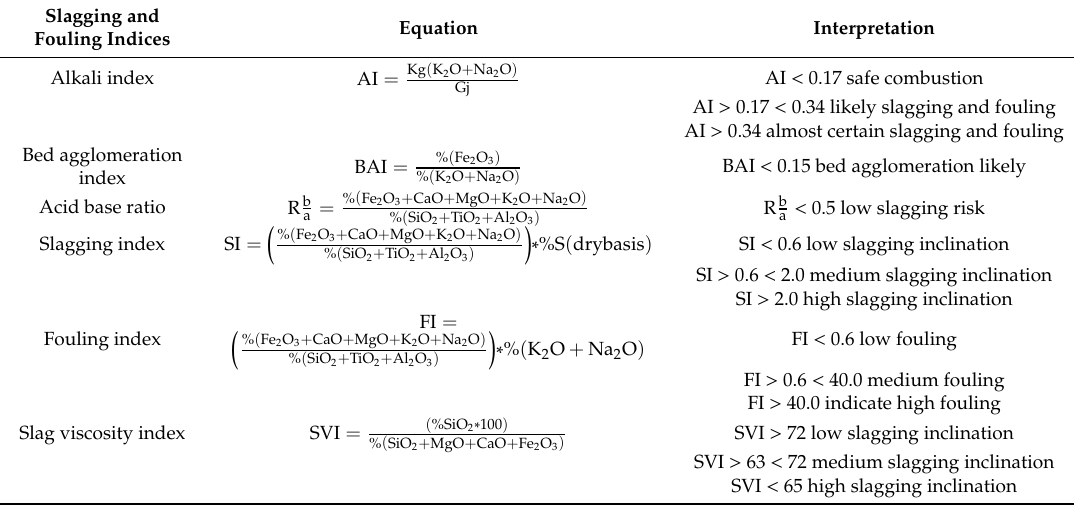
Table 1. Predictive slagging and fouling